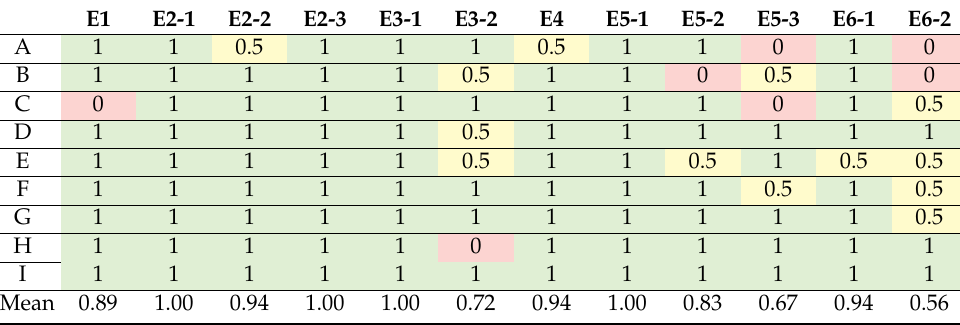
Table 11. Application levels for each key idea. Ex stands for the application level of the student with regard to key idea x, cf. Tables A1–A6. The responses are color coded such that 1 is green, 0.5 is yellow and 0 is